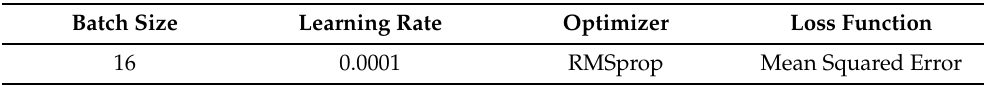
Table 1. Hyper-parameters used for training. Batch Size Learning